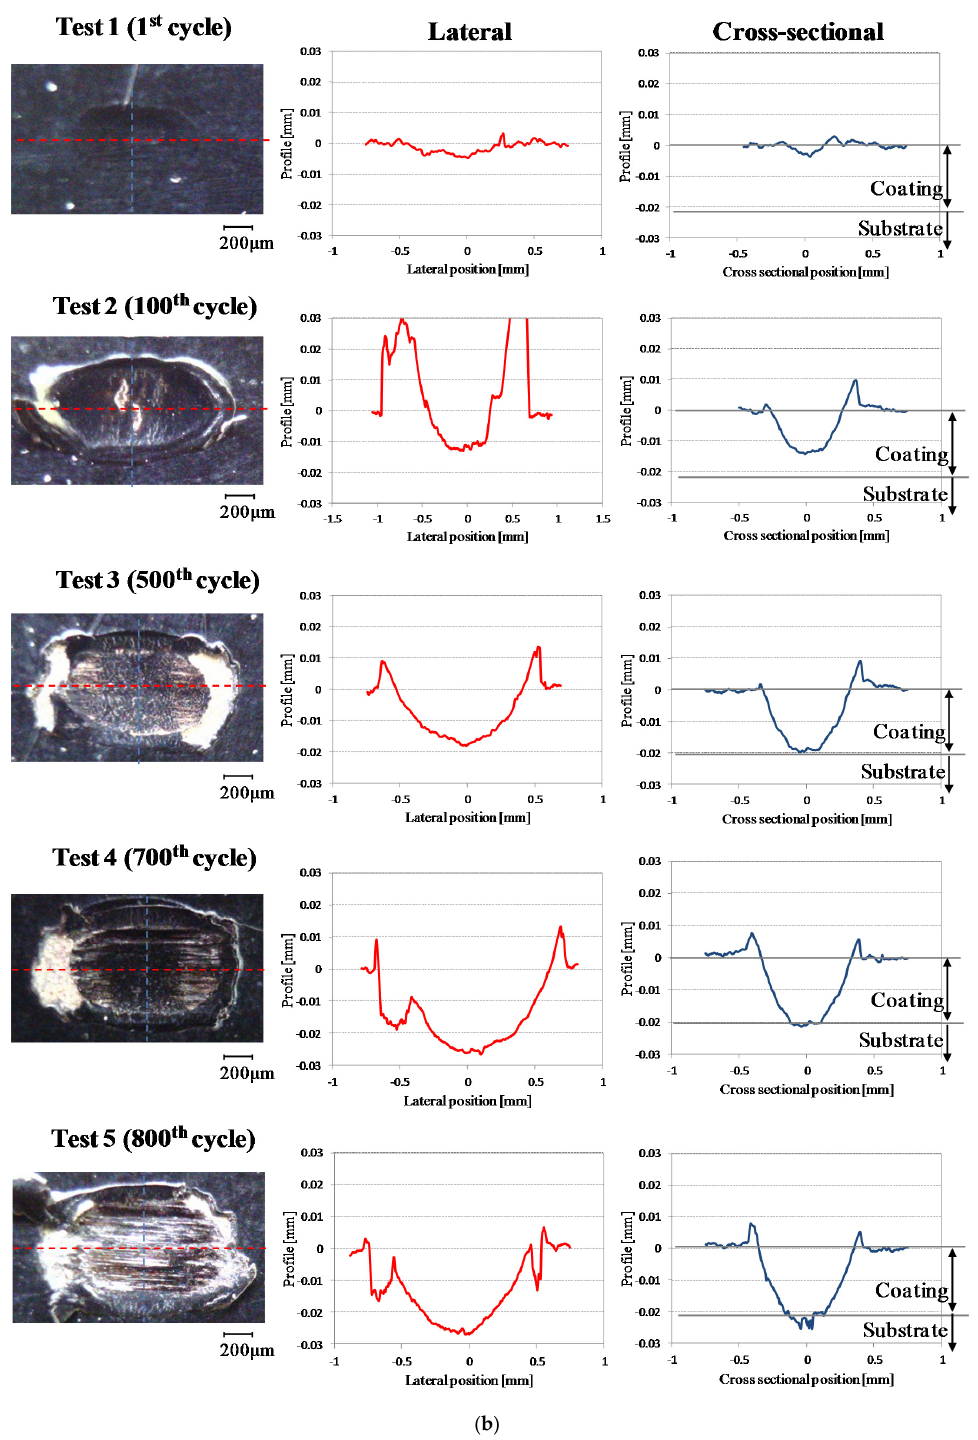
Figure 8. Measurement of the friction coefficient and observation of fretted surfaces: ( a ) the friction coefficient evolution; ( b ) worn surface images (250×) and surface profiles. Note that the initial coating thickness was 0.022 mm. Bright areas near contact edges were associated with reflection of light in a microscope.